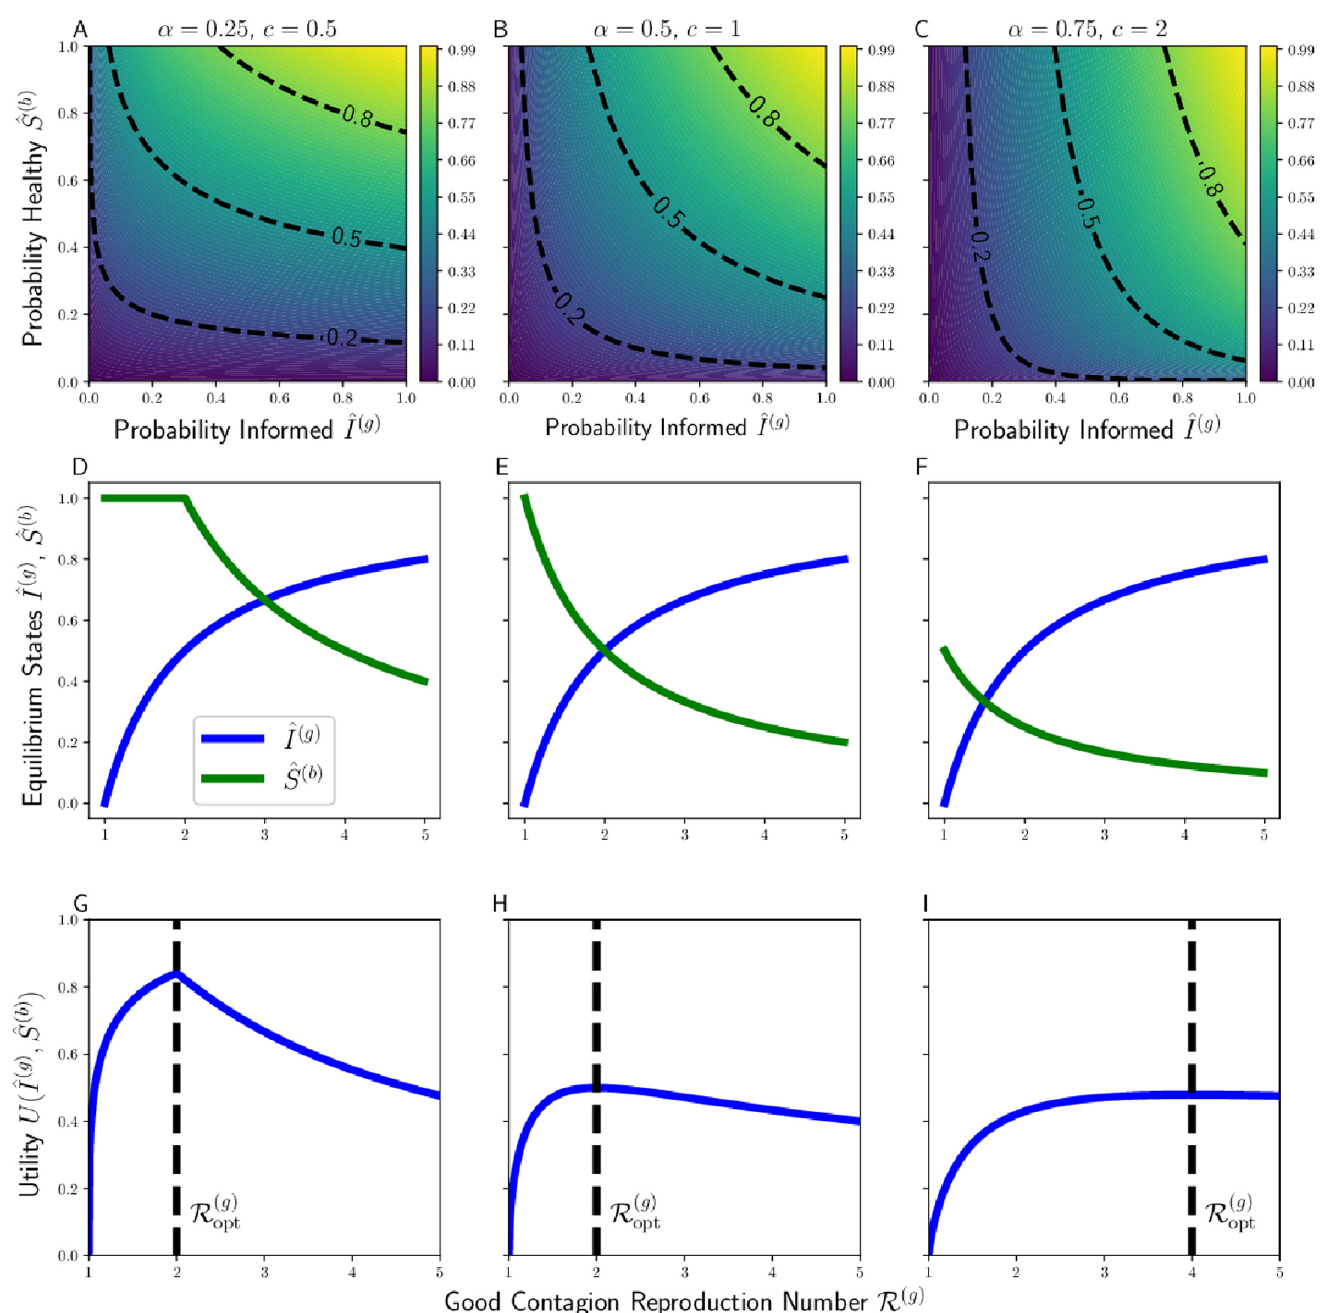
Fig 1. Example heatmaps of Cobb-Douglas utility for various weights α of emphasis on acquiring the good contagion versus avoiding the bad contagion ( A–C ), endemic equilibria ^ I ð g Þ and ^ S ð b Þ as a function of sociality strategy R ð g Þ for different values of relative transmissibility c ( D–F ), and resultant overall utilities as a function of R ð g Þ given α and c ( G–I ). Note that in certain cases (e.g. G ) utility is maximized by setting R ð g Þ ¼ 1 contagion fails to spread. Vertical dashed lines in G–I correspond to the socially-optimal sociality strategy R ð g Þ